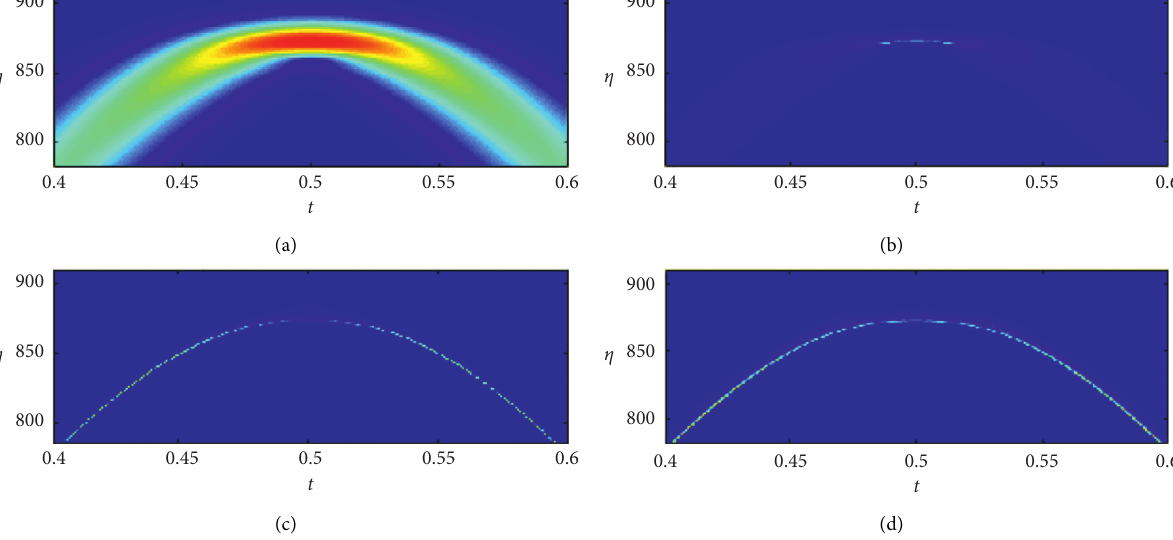
Figure 3: Local enlarged images of high-frequency bands marked by yellow rectangle in Figure 2: (a) STFT, (b) FSST, (c) OSST, and (d) VSST.